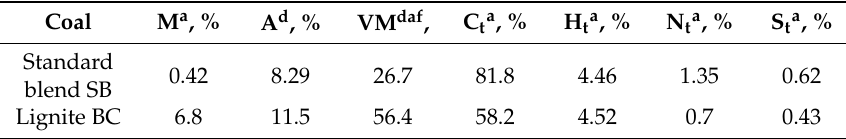
Figure 1. General view of prepared briquettes. Table 1. Properties of used coking blend and brown coal.